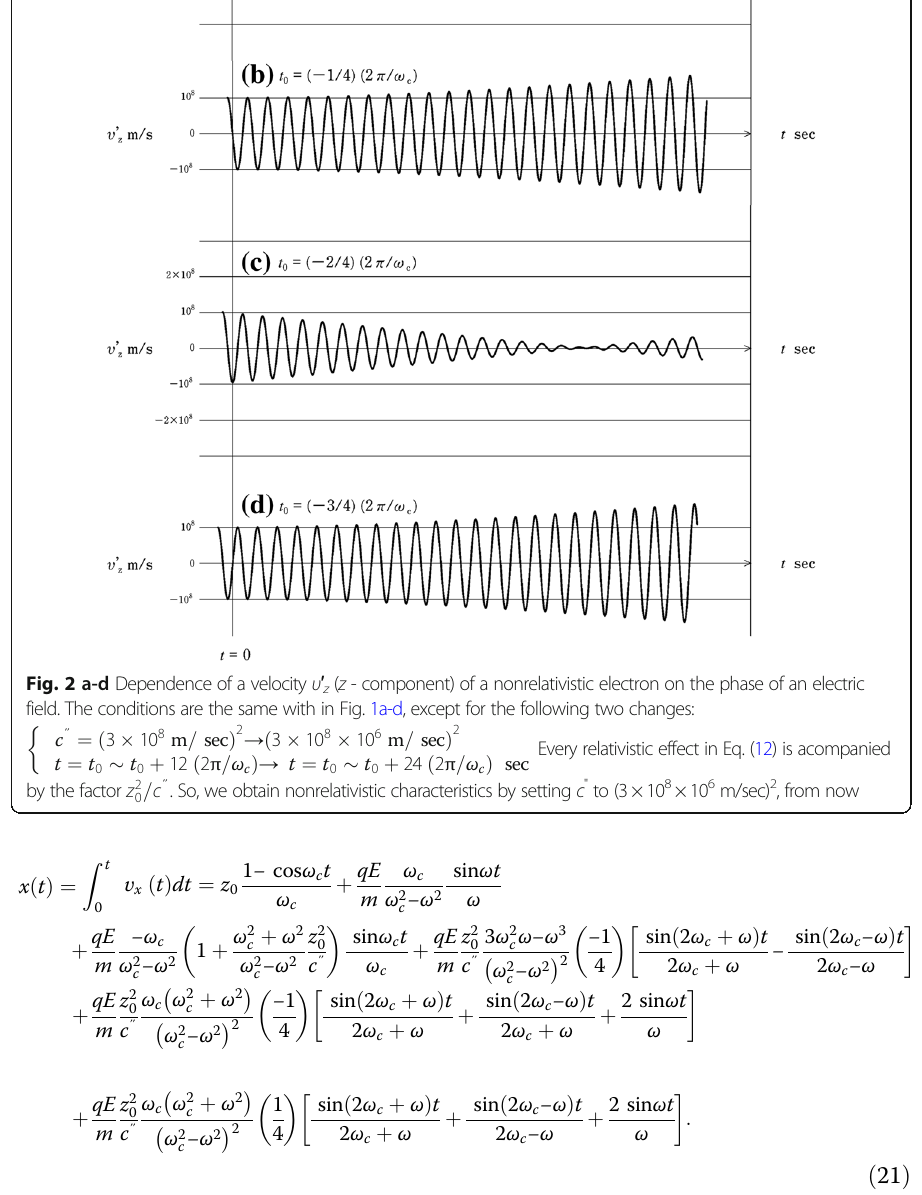
In the case where ω c / ω = 1.0001, we examine dependences of Eq. (12) on the phase of an electric field. The results are shown in Figs. 1a-d and 2a-d. An electron starts at the origin with an initial velocity + ^ z 10 8 m/s at four different phases of time t / ω c ), ( − 2/4) (2 π / ω c ), ( − 3/4) (2 π / ω c ), where 2 π / ω c ( ≃ 2 π / ω ) is almost the period of the